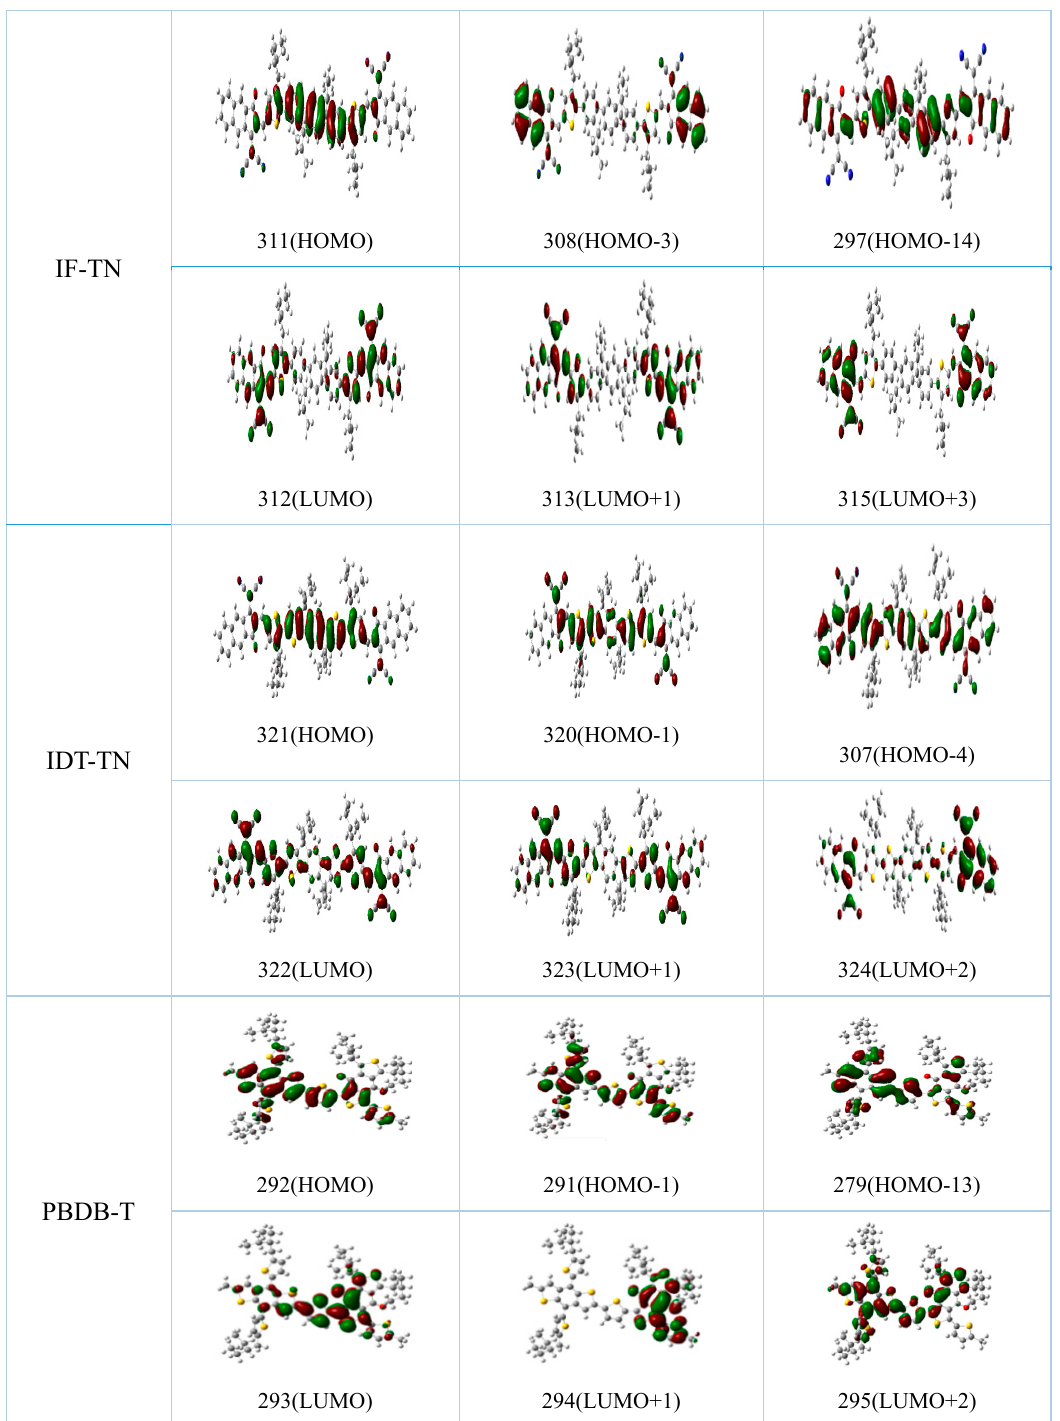
Figure 2. The frontier molecular orbital plots of the NFAs IF-TN and IDT-TN, and donor PBDB-T (where the red color represents electrons and green represents holes).